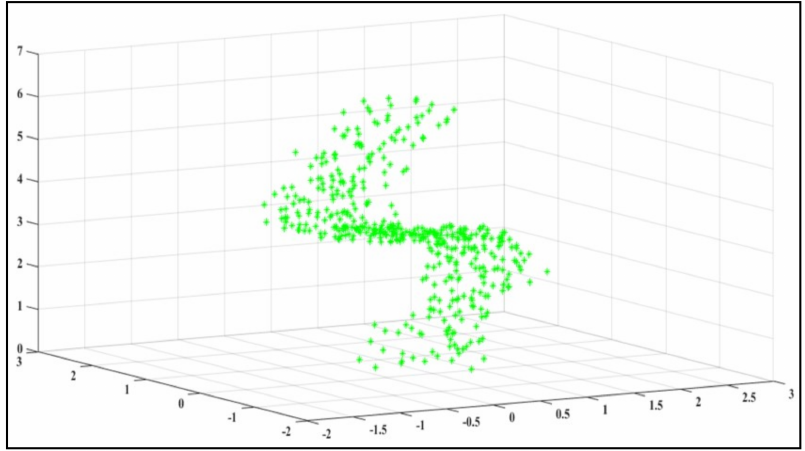
Figure 5. Effective hybrid